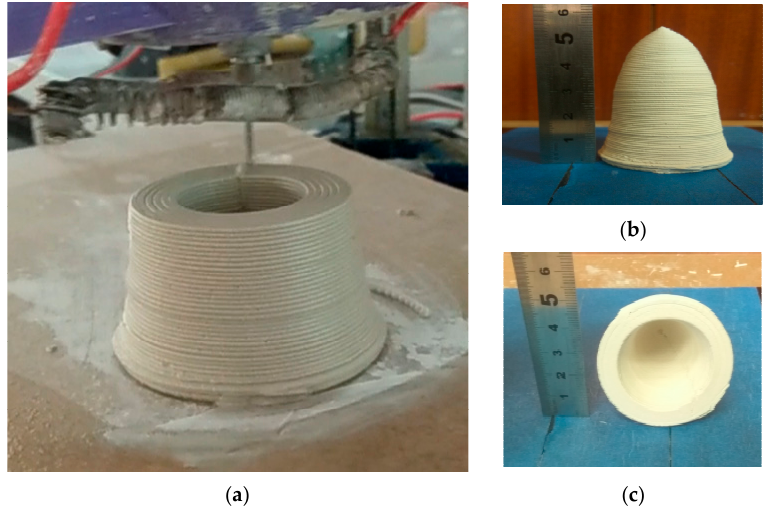
Figure 13. Three-dimensional printing of the fire arrowhead-like object with in situ hot air flow drying: ( a ) extrusion-based 3D printing, ( b ) finalized object, and ( c ) smooth intracavity.